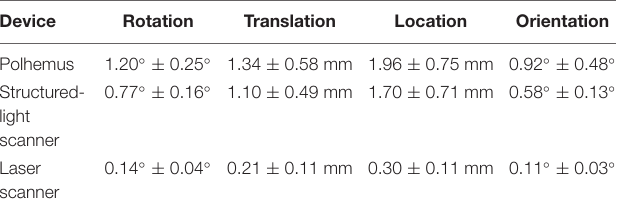
TABLE 5 | Repeatability error of each device in the human experiment.